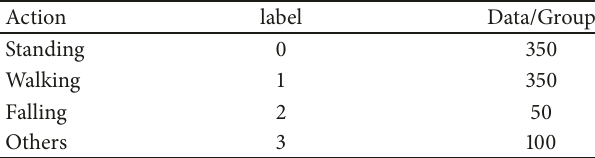
Table 1: Data Distribution of Different Action